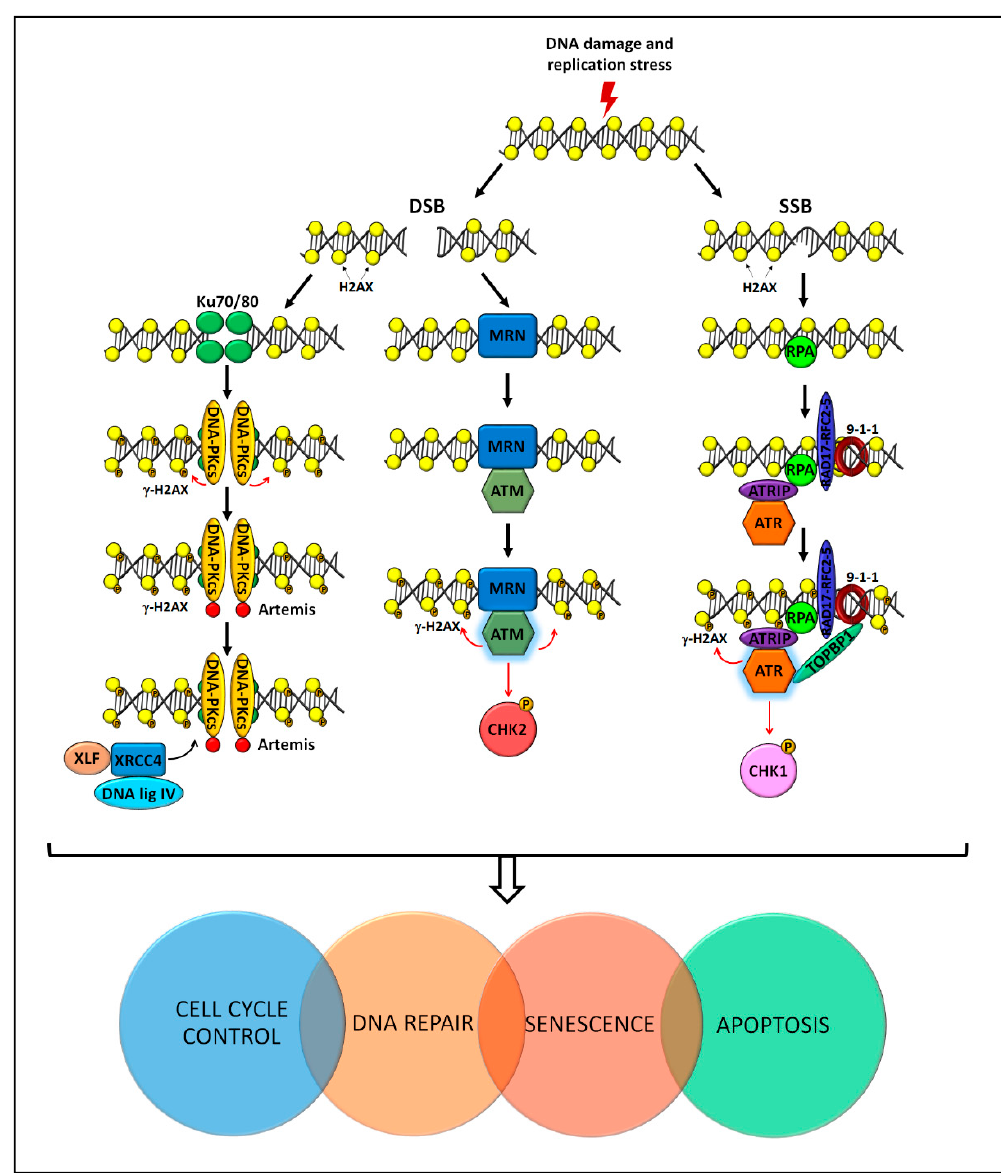
Figure 3. The DNA damage response (DDR) pathway involves sensor, transducer, mediator/amplifier, and effector proteins, which act following the induction of a DNA lesion or replication stress. The induction of single-strand breaks (SSB) or double-strand breaks (DSB) activates specific DDR kinases (i.e., DNA-PK, ATM, and ATR). In turn, this allows the activation of genes and proteins involved in cell cycle control and DNA repair. In the presence of highly damaged cells, apoptosis and senescence are activated to deplete or to semi-permanently arrest cells, respectively. For detail, see the text. X-Ray Repair Cross Complementing 6 (Ku70); X-Ray Repair Cross Complementing 5 (Ku80); catalytic subunit of DNA protein kinases (DNA-PKcs); phosphorylated H2A Histone Family Member X ( γ H2AX); Non-Homologous End Joining Factor 1 (XLF); X-Ray Repair Cross Complementing 4 (XRCC4); DNA ligase IV (DNA lig IV); MRE11/RAD50/NBS1 (MRN); Ataxia Telangiectasia Mutated (ATM); Checkpoint Kinase 2 (Chk2); Replication Protein A (RPA); Rad3-Related-Interacting Protein (ATRIP); DNA Topoisomerase II Binding Protein 1 (TOPBP1); Ataxia Telangiectasia and Rad3-Related Protein (ATR); Checkpoint Kinase 1 (Chk1).